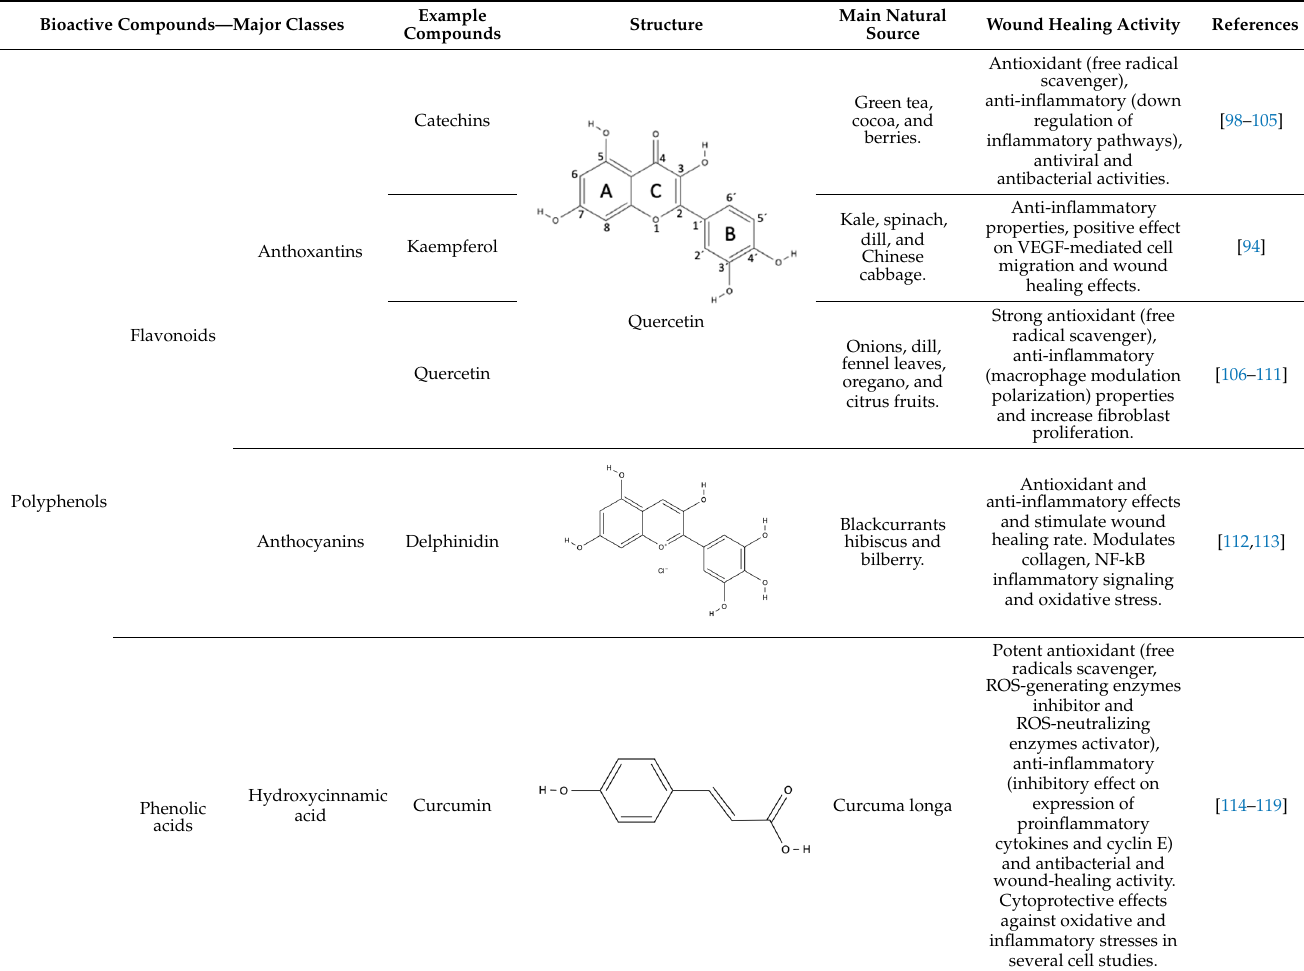
Table 1. Major classes of natural bioactive compounds, structure, main sources, and their therapeu- tic targets for wound-healing activity.